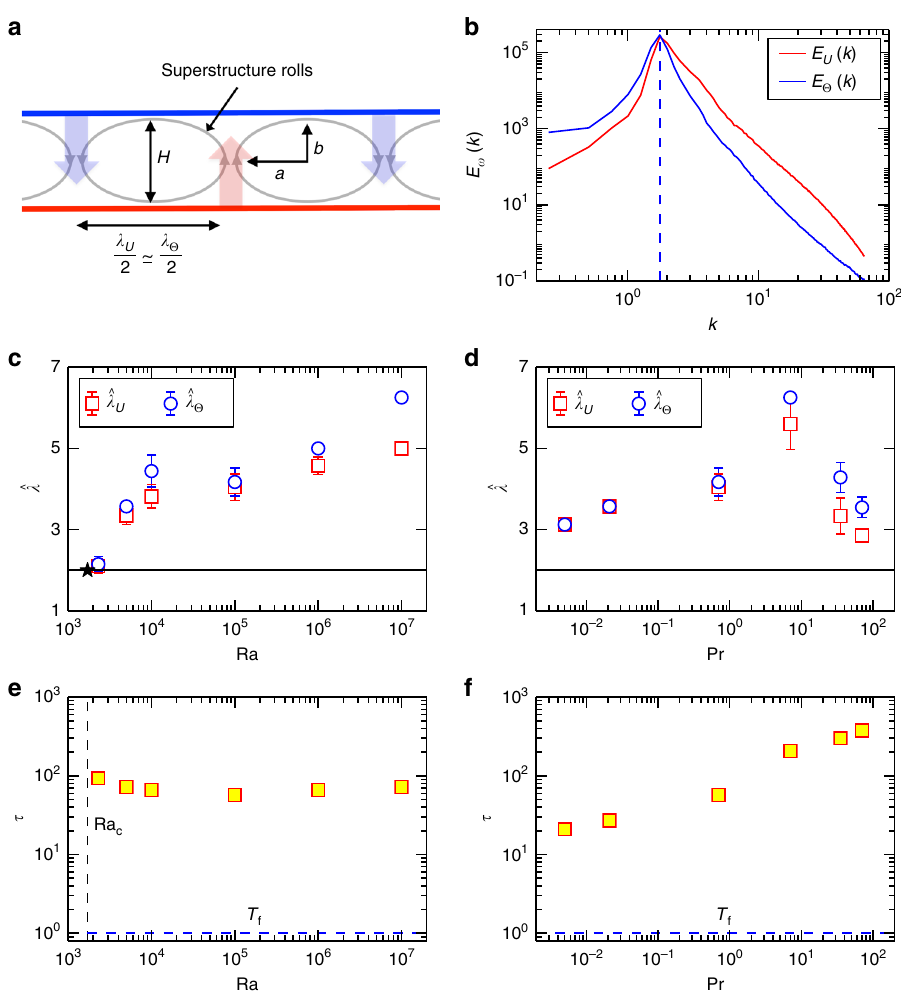
Fig. 4 Characteristic times and scales of turbulent superstructure patterns. a Sketch of the turbulent superstructure with the rolls (or cells) formed by upwelling hot and downwelling cold fl uid. The characteristic scale of the superstructures is half the roll pattern wavelength, ^ λ U ; Θ . b Azimuthally averaged power spectra, E U ( k ) and E Θ ( k ). Data are for Pr = 0.021 and Ra = 10 5 as an example. The power spectra are determined for each snapshot and then averaged over all snapshots. Maximum wavenumbers of both power spectra are indicated by the vertical dotted line. c Rayleigh number dependence of characteristic wavelength ^ λ U ; Θ of the superstructures for turbulent convection in air. d Prandtl number dependence of characteristic wavelength of superstructures at Ra = 10 5 . All error bars are plotted though some are too small to see. The error bars are given by ± Δ ^ λ U ; Θ ¼ ð 2 π = k (cid:4) 2 U ; Θ Þ Δ k with t k (cid:4) t Δ k ¼ max ð k (cid:4) U ; Θ ð U ; Θ ð 0 ÞÞ (cid:3) min ð 0 ÞÞ . The solid lines in c , d mark the critical wavelength Characteristic time τ as a function of Rayleigh number at Pr = 0.7. f Characteristic time as a function of the Prandtl number at Ra = 10 5 . The free-fall time, T f , is also indicated in both panels as a horizontal dashed line. The vertical dashed line in panel e stands for Ra given in units of height H , characteristic times in units of T